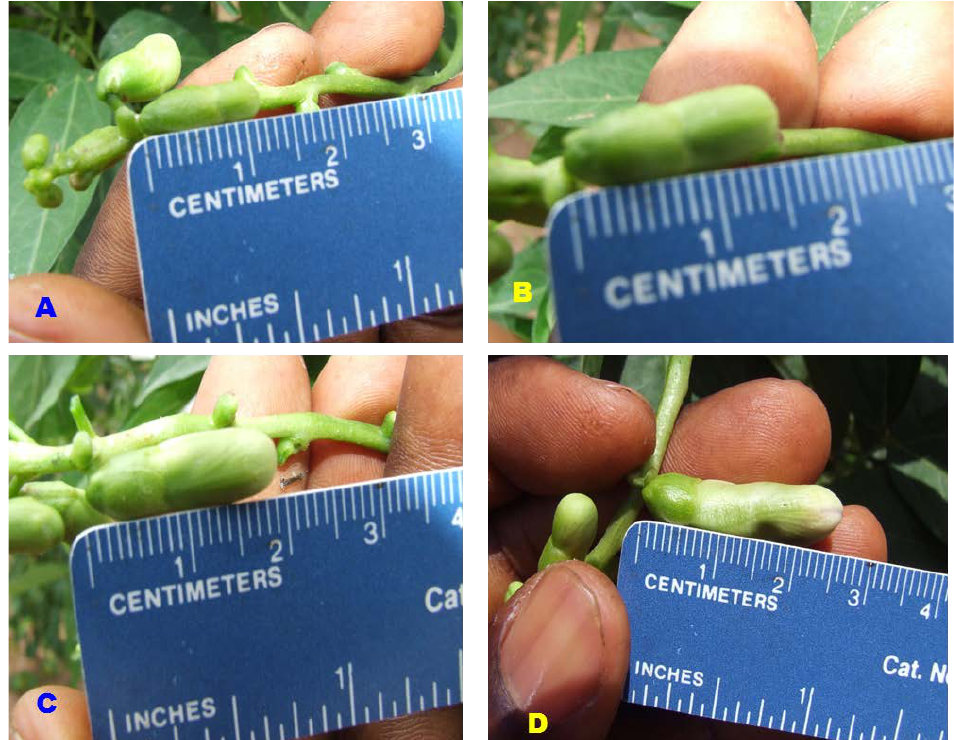
Fig. 2. Progressive length measurements of the flower buds of African yam bean A - Flower bud length of about 1.0 cm; B - Flower bud length of about 1.5 cm; C - Flower bud length of about 2.0 cm; D - Flower bud length of about 2.5 cm